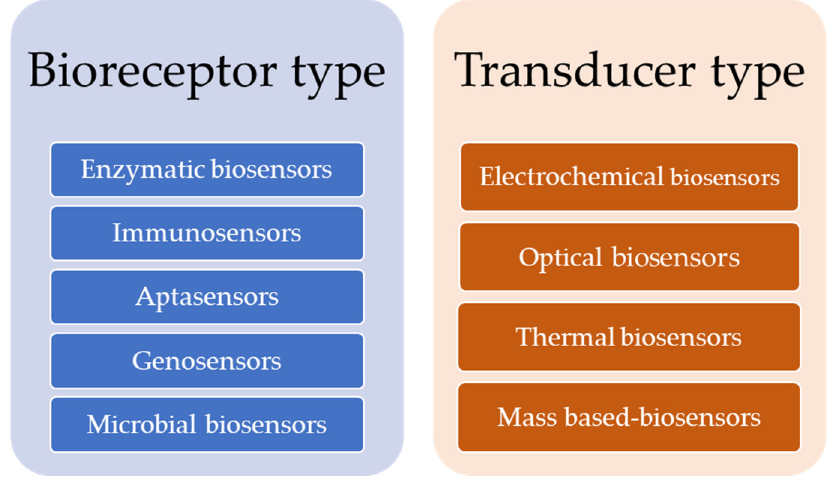
Figure 2. Classification of biosensors.